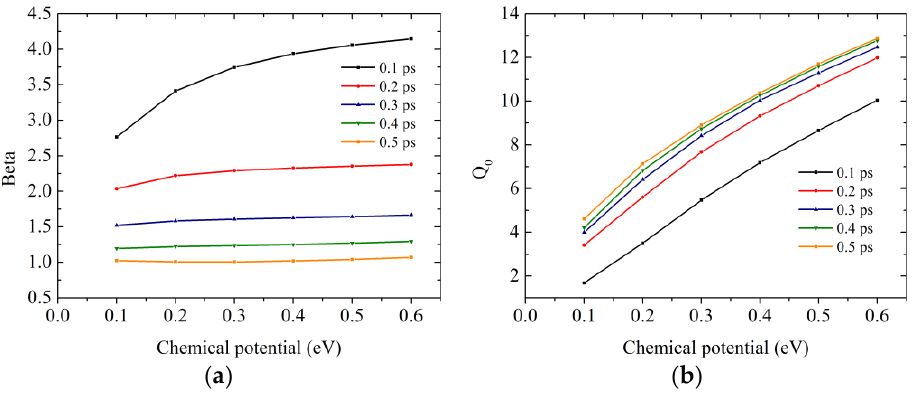
Figure 7. The calculated circuit parameter results versus chemical potential with different relaxation times. ( a ) β and ( b ) Q 0 curves with the graphene relaxation time from 0.1 ps to 0.5 ps over different chemical potentials.